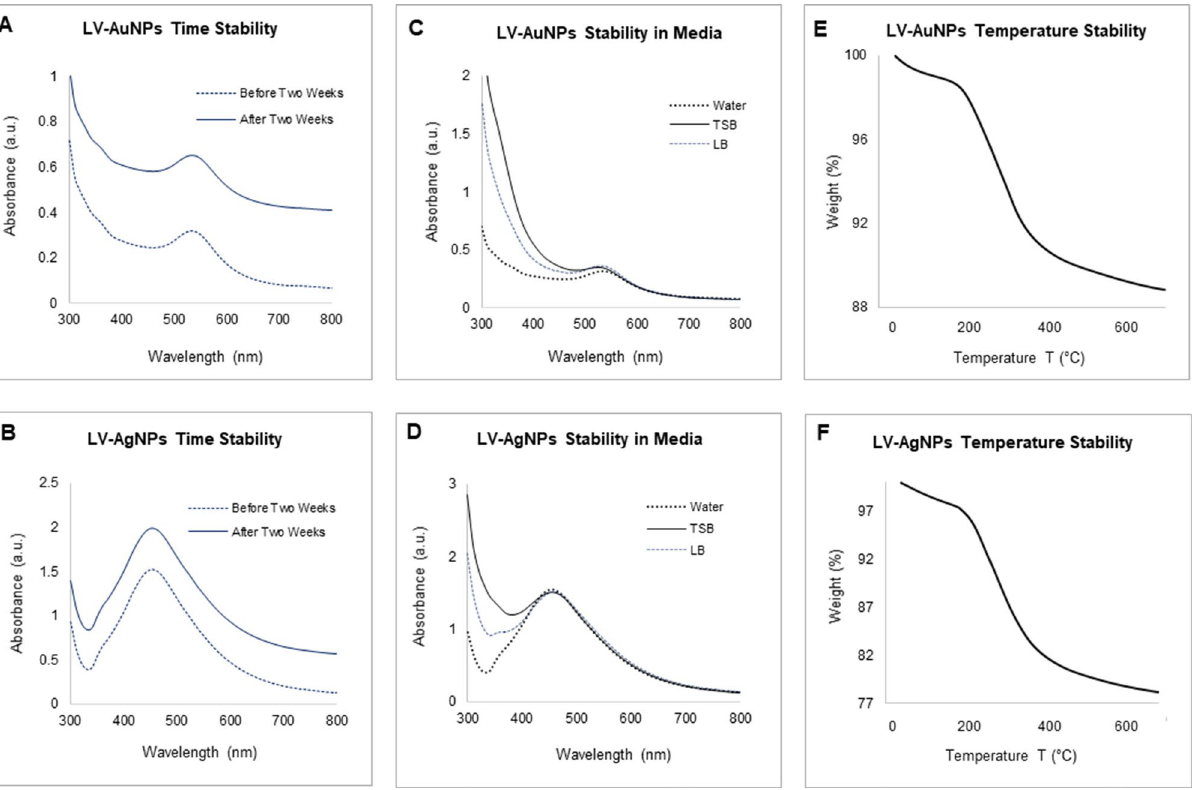
Figure 6. UV-Vis spectrum representing the stability analysis, before and after two weeks of incubation at RT for (A) LV-AuNPs, and (B) LV-AgNPs; in a different medium (C) LV-AuNPs, (D) LV-AgNPs; at the temperature range from 20-700 °C measured by TGA instrument (E) LV-AuNPs, (F) LV-AgNPs.